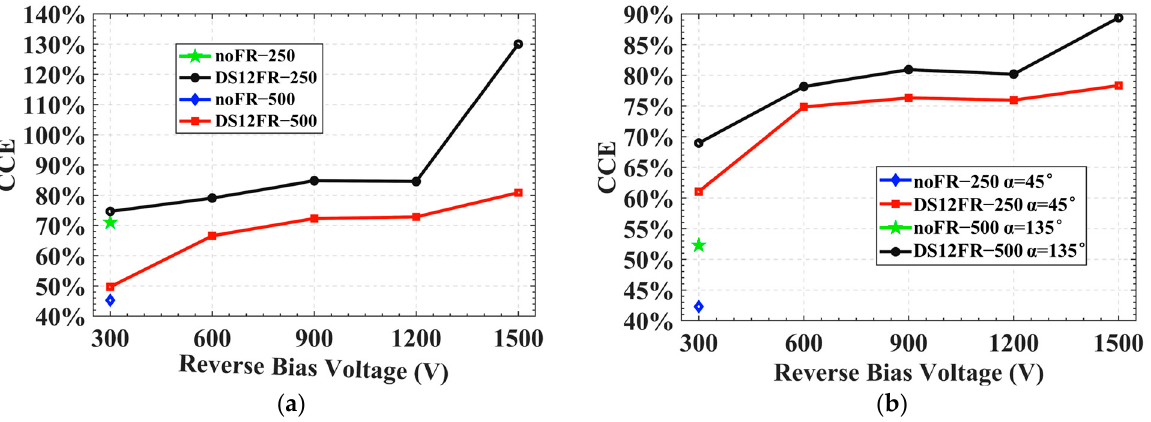
Figure 12. Charge collection efficiency: ( a ) Incident at D = 250 μ m and D = 500 μ m vertical surfaces, respectively; ( b ) Incident at α = 45° and α = 135°, respectively.